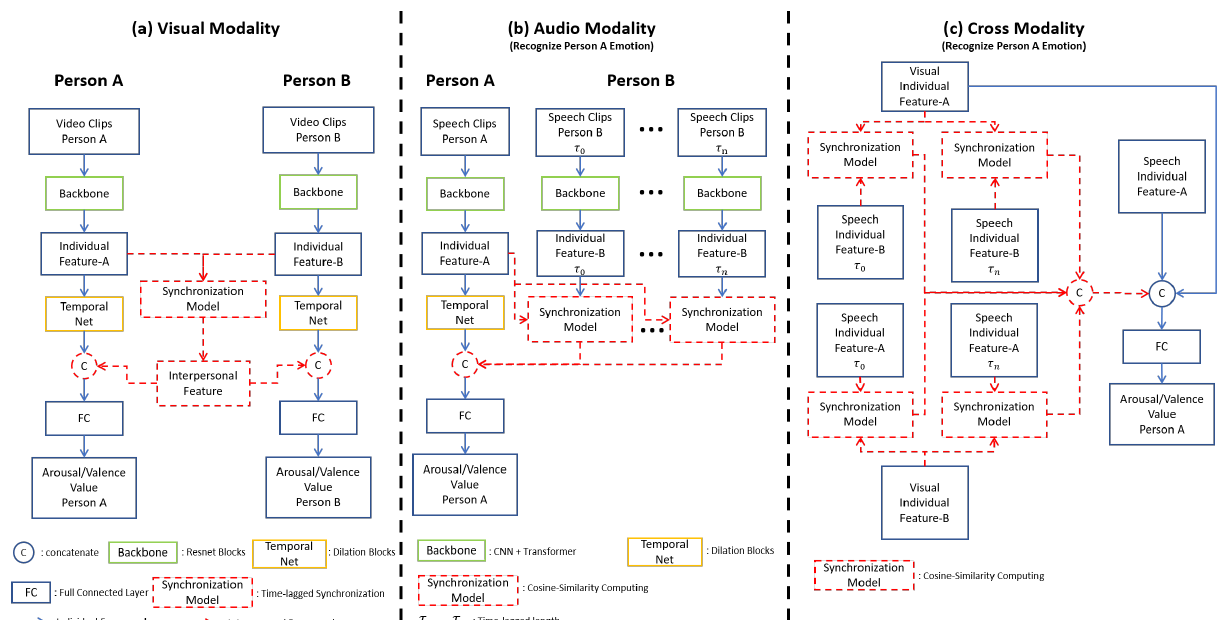
Figure 2. Individual and interpersonal models in visual, audio, and cross-modality.